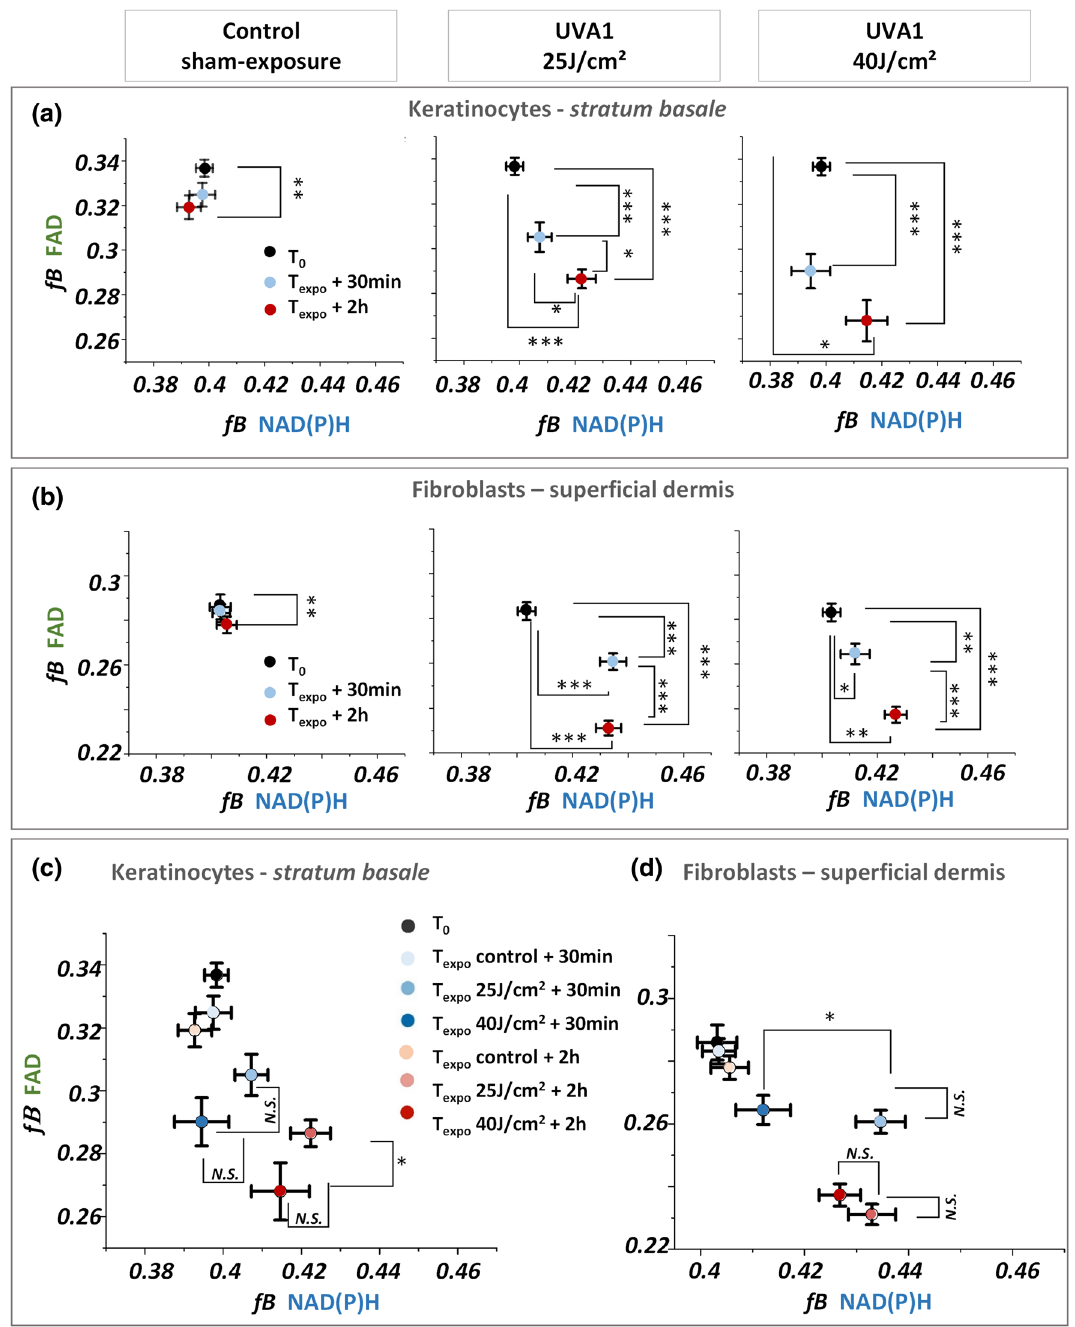
Figure 5. Temporal changes in the fractions of bound NAD(P)H ( f B NAD(P)H) and bound FAD ( f B FAD) in keratinocytes and fibroblasts of reconstructed human skin upon different UVA1 doses . ( a , b ) Fractions of bound NAD(P)H and bound FAD of basal keratinocytes ( a ) and superficial dermal fibroblasts ( b ) exposed to different UVA1 doses or control-sham exposure. ( c )–( d ) Same quantification data as in ( a ) and ( b ), regrouped to highlight the sensitivity to UVA1 doses of NAD(P)H and FAD biomarkers in the basal ( c ) and dermal layers ( d ) of reconstructed human skin. Data are presented as mean ± s.e.m. N.S. indicates distributions that are not statistically different and * indicates distributions that are statistically different (* p < 0.05, ** p < 0.01 and *** p <